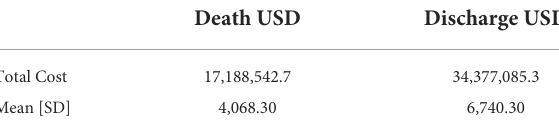
TABLE 3 The direct medical cost of hospital services for hospitalized patients diagnosed with COVID-19 and